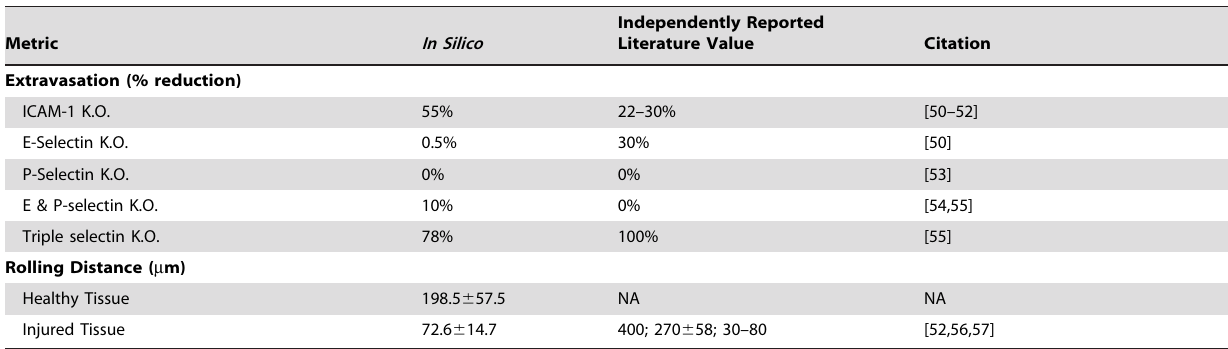
Table 2. Verification of monocyte trafficking